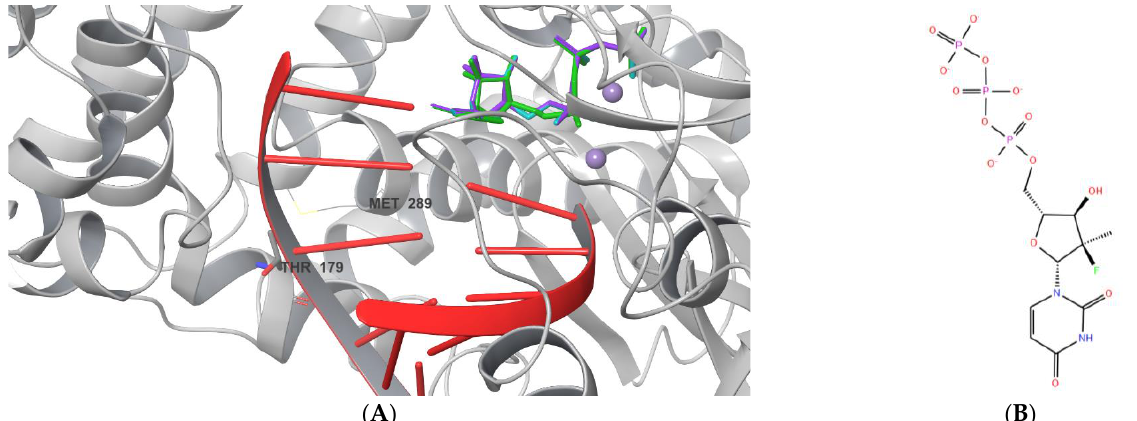
Figure 1. The docked poses of GS − 461203 ( A ) in WT (green), T179A (blue) and M289L (purple), two manganese ions (purple), with the positions of mutated residues; and the chemical structure of the drug ( B ).